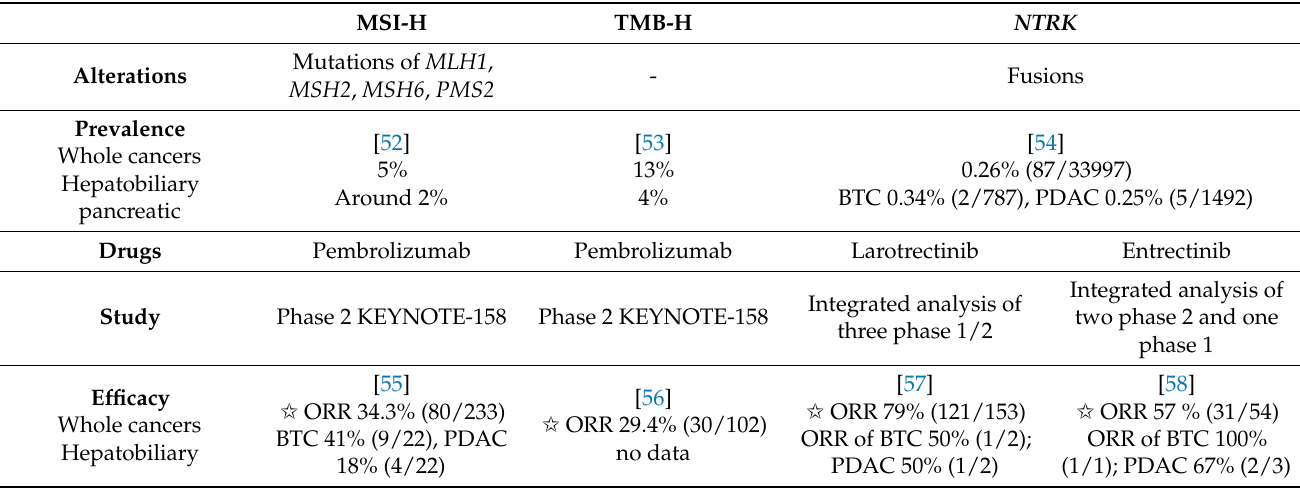
Table 2. Tumor-agnostic biomarkers and treatment results for hepatobiliary and pancreatic cancers. MSI-H TMB-H